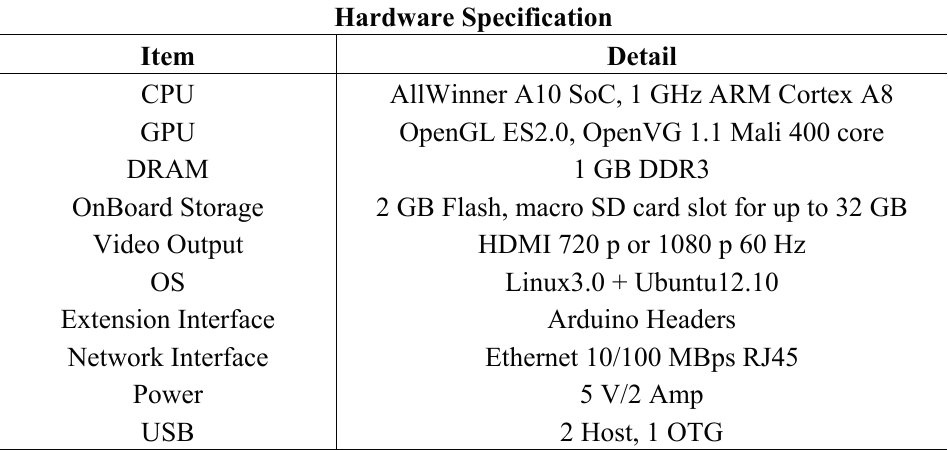
Table 3. AllWinner A10SoC mini PC platform. [30]